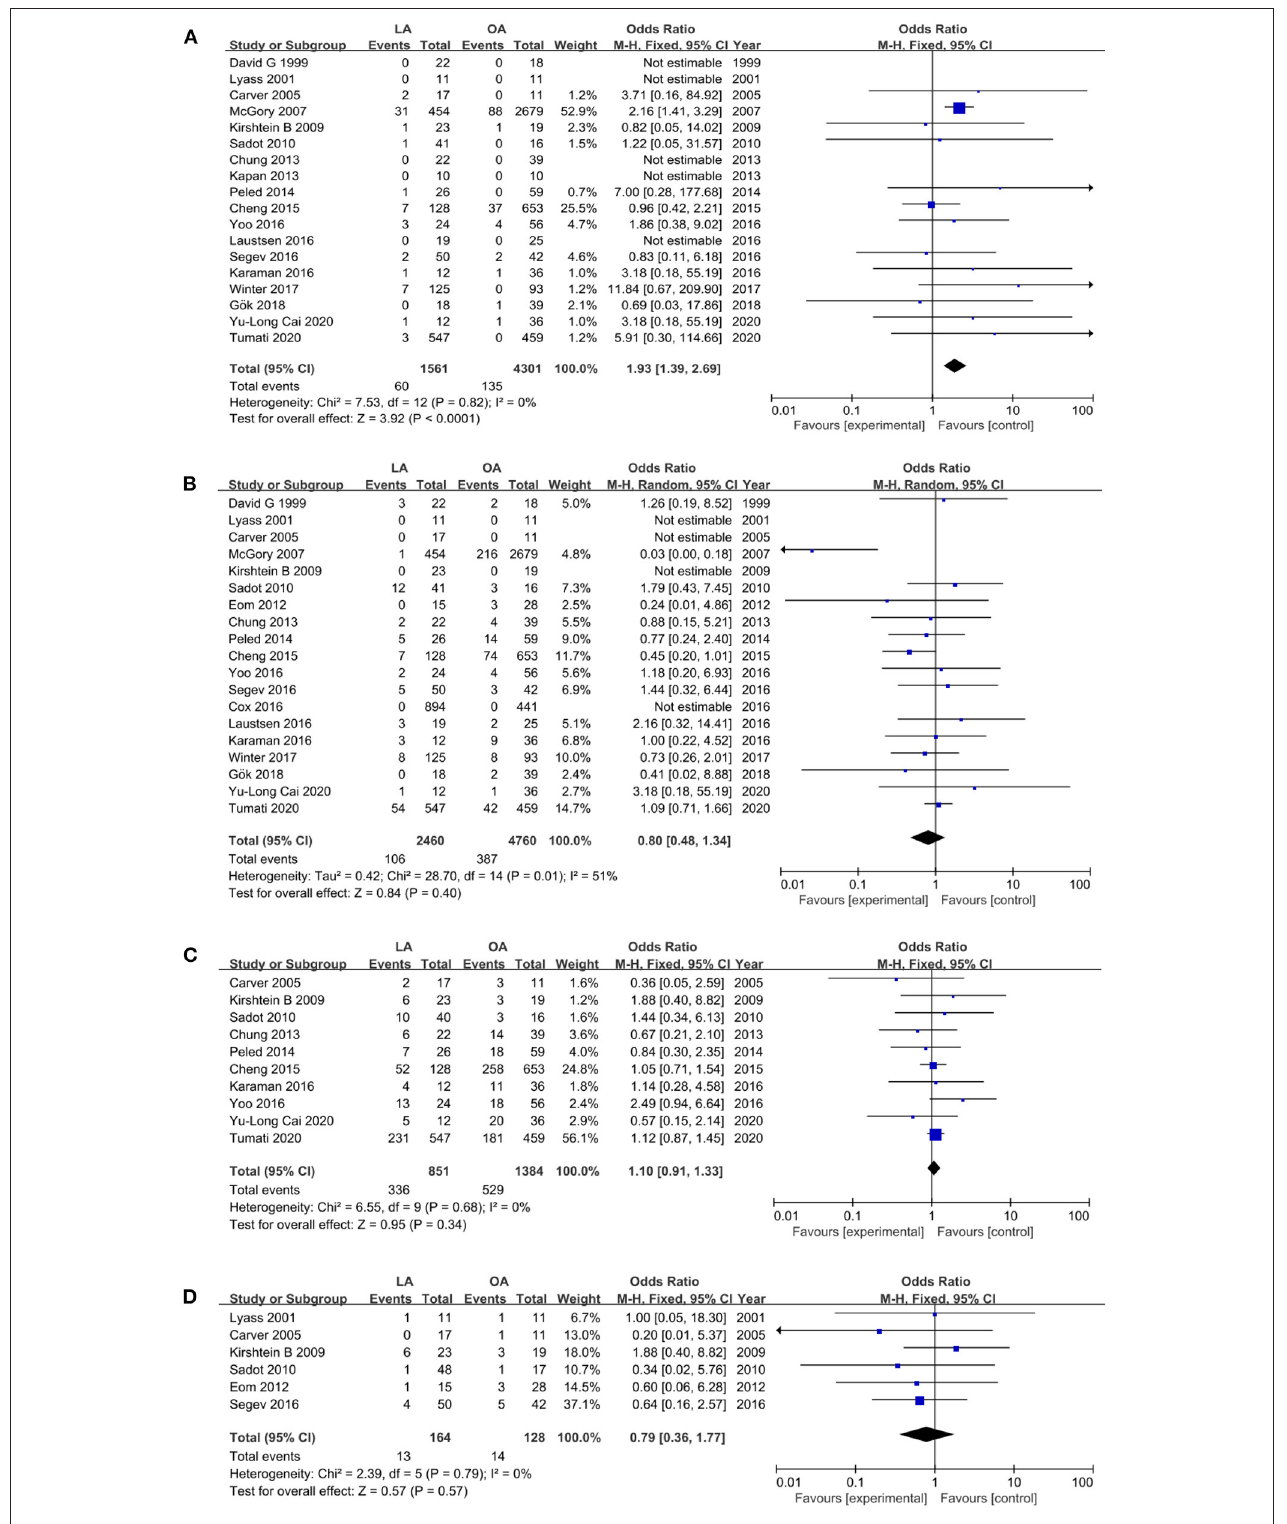
FIGURE 2 | Forest plot of the obstetrical outcomes comparison of LA vs. OA. (A) Forest plot for fetal loss (OR 1.93, 95% CI 1.39–2.69, P < 0.0001); (B) Forest plot for pre-term delivery (OR 0.80, 95% CI 0.48–1.34, P = 0.40); (C) Forest plot for cesarean section (OR 1.10, 95% CI 0.91–1.33, P = 0.34); (D) Forest plot for post-operative uterine contraction (OR 0.79, 95% CI 0.36–1.77, p = 0.57).